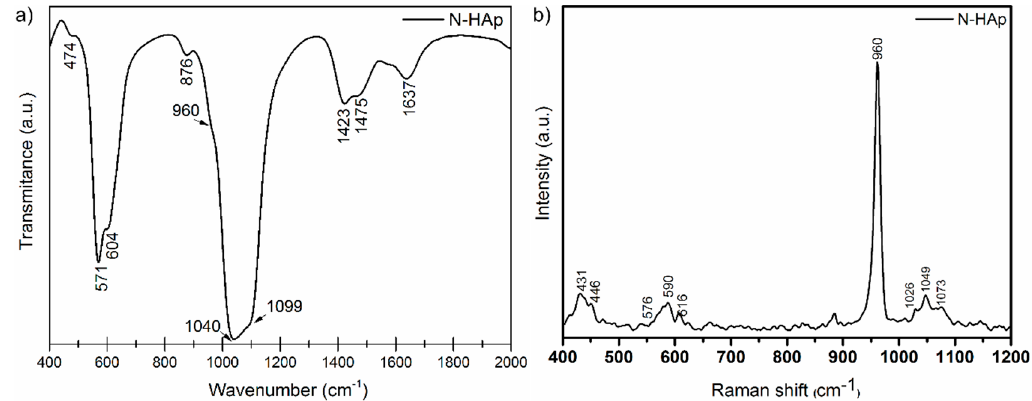
Figure 2. FTIR ( a ) and Raman ( b ) spectra of N-HAp nanopowders.